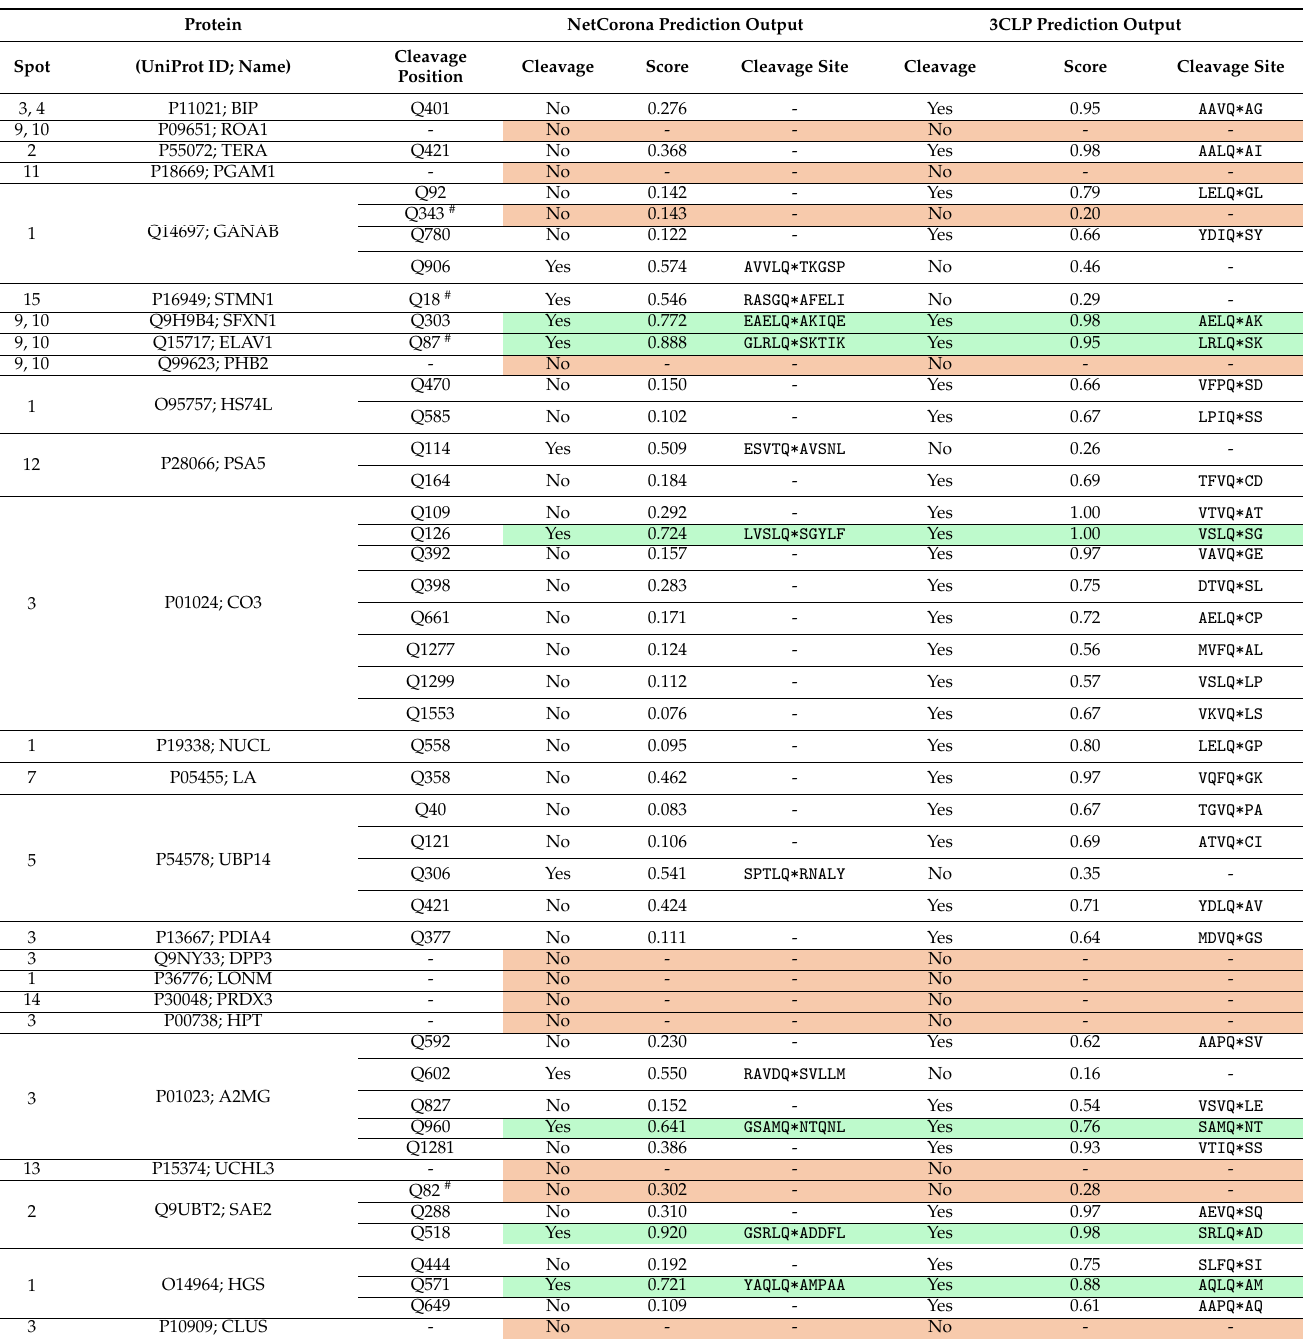
Table 1. Predicted cleavage sites of SARS-CoV-2 Mpro in cleavage sites in potential substrates identified by 2D-DIGE. Proteins identified in the spots with statistically significant differences between mock- and SARS-CoV-2 Mpro-transfected cells are listed. The name of the proteins and the unique identifiers are shown based on the UniProt database. The cleavage sites were predicted using NetCorona and 3CLP web servers. Potential cleavage sites which were identified by both methods are highlighted with a light green background, while the light orange background indicates that none of the algorithms predicted the existence of any cleavage site. Sequences are shown only in those cases if they were predicted to contain a potential cleavage site. White background indicates that the given site was identified by only one of the algorithms. # These cleavage sites have been identified previously by Koudelka et al.